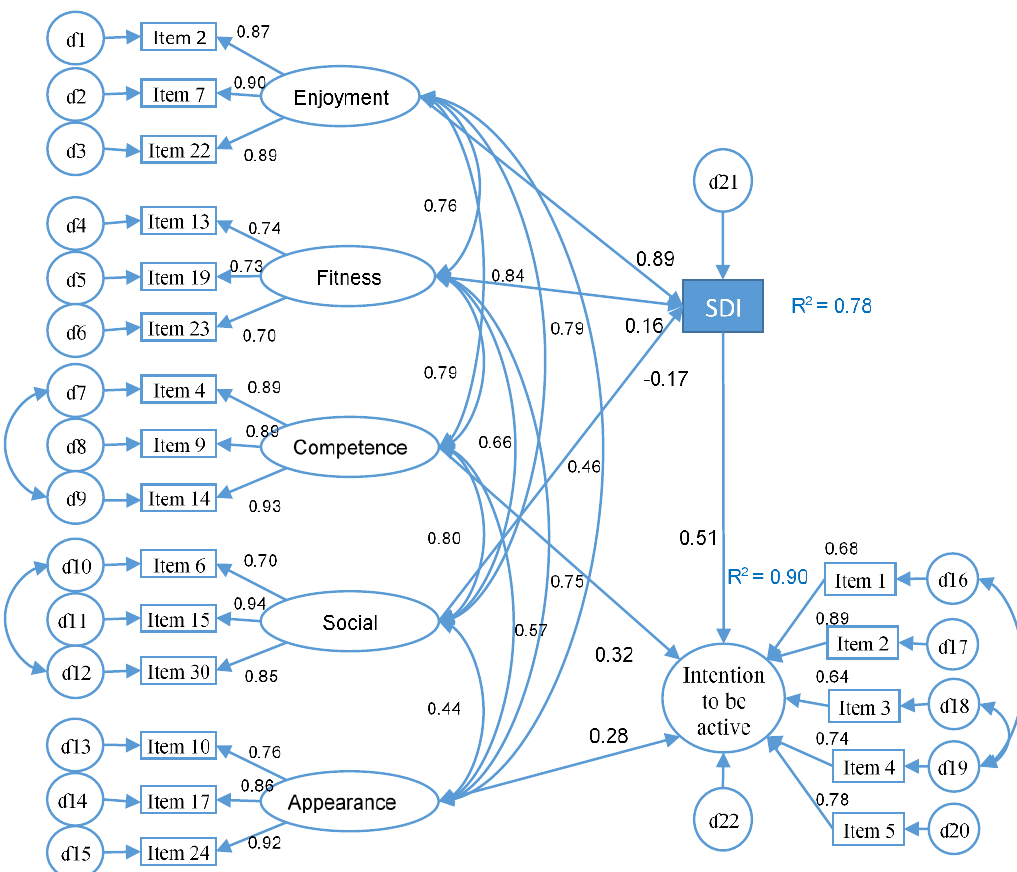
Figure 2. Structural equation model 2 in university students.